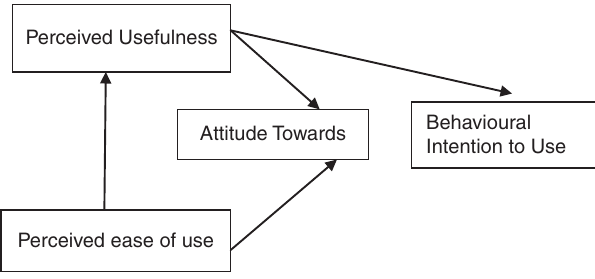
Figure 4. Model used